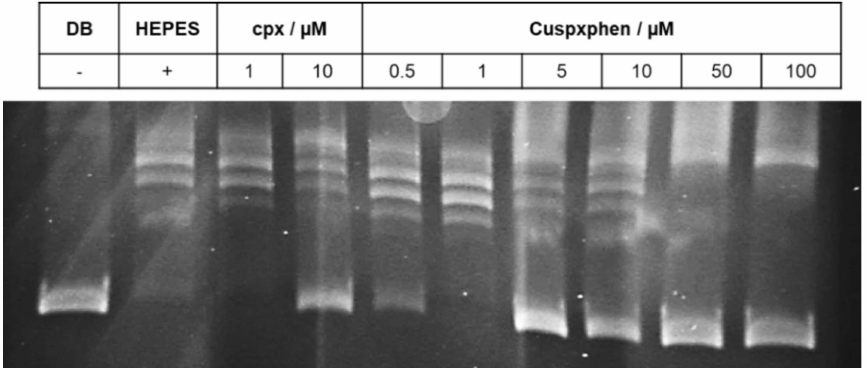
Figure 2. Topoisomerase IV relaxation inhibition assay obtained for Cuspxphen as enzymatic inhibitor of the S. aureus topoisomerase IV, performed with 0.5 µ L of supercoiled pBR322 plasmid, determined in a 1% ( w / v ) agarose gel in TAE bu ff er. DB is dilution bu ff er and the respective band is the negative control, containing the relaxed plasmid in the absence of the enzyme. HEPES is the positive control containing the enzyme and the plasmid. The cpx bands represent the drug control. µ M means µ mol dm − 3 and refers to the concentration of the compound. The experiment was also performed with the E.